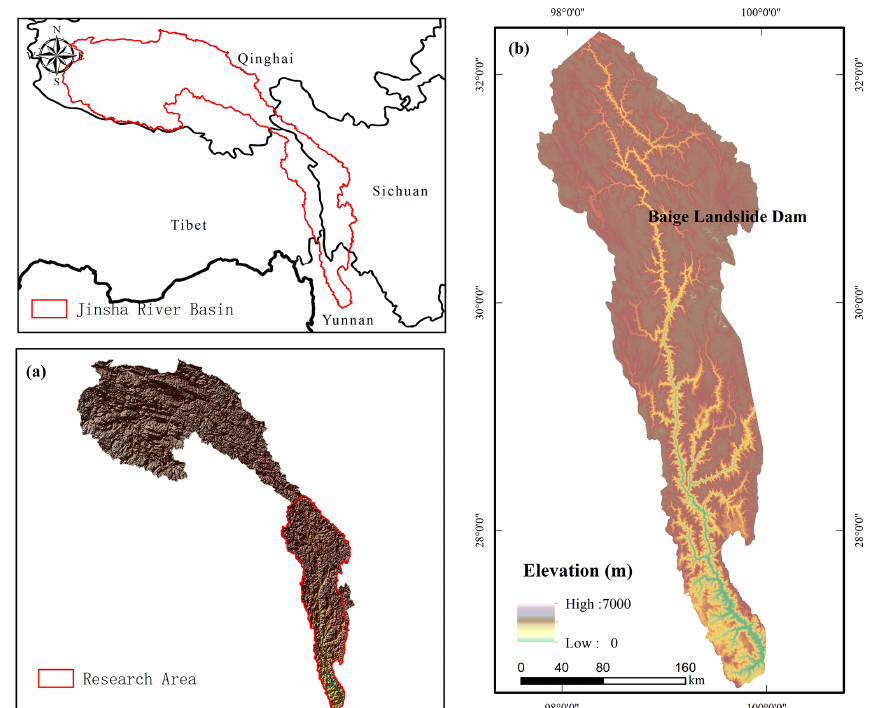
Figure 5. The position of the Baige landslide